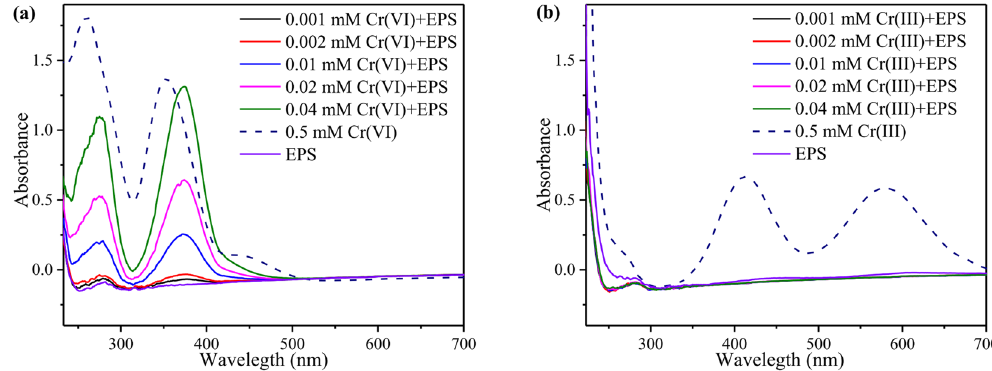
Figure 3. UV-visible spectra analysis. ( a ) Differentiated spectra of EPS, Cr(VI) and the mixture of EPS and Cr(VI) at various Cr(VI) dosages; ( b ) differentiated spectra of EPS, Cr(III) and the mixture of EPS and Cr(III) at various Cr(III)